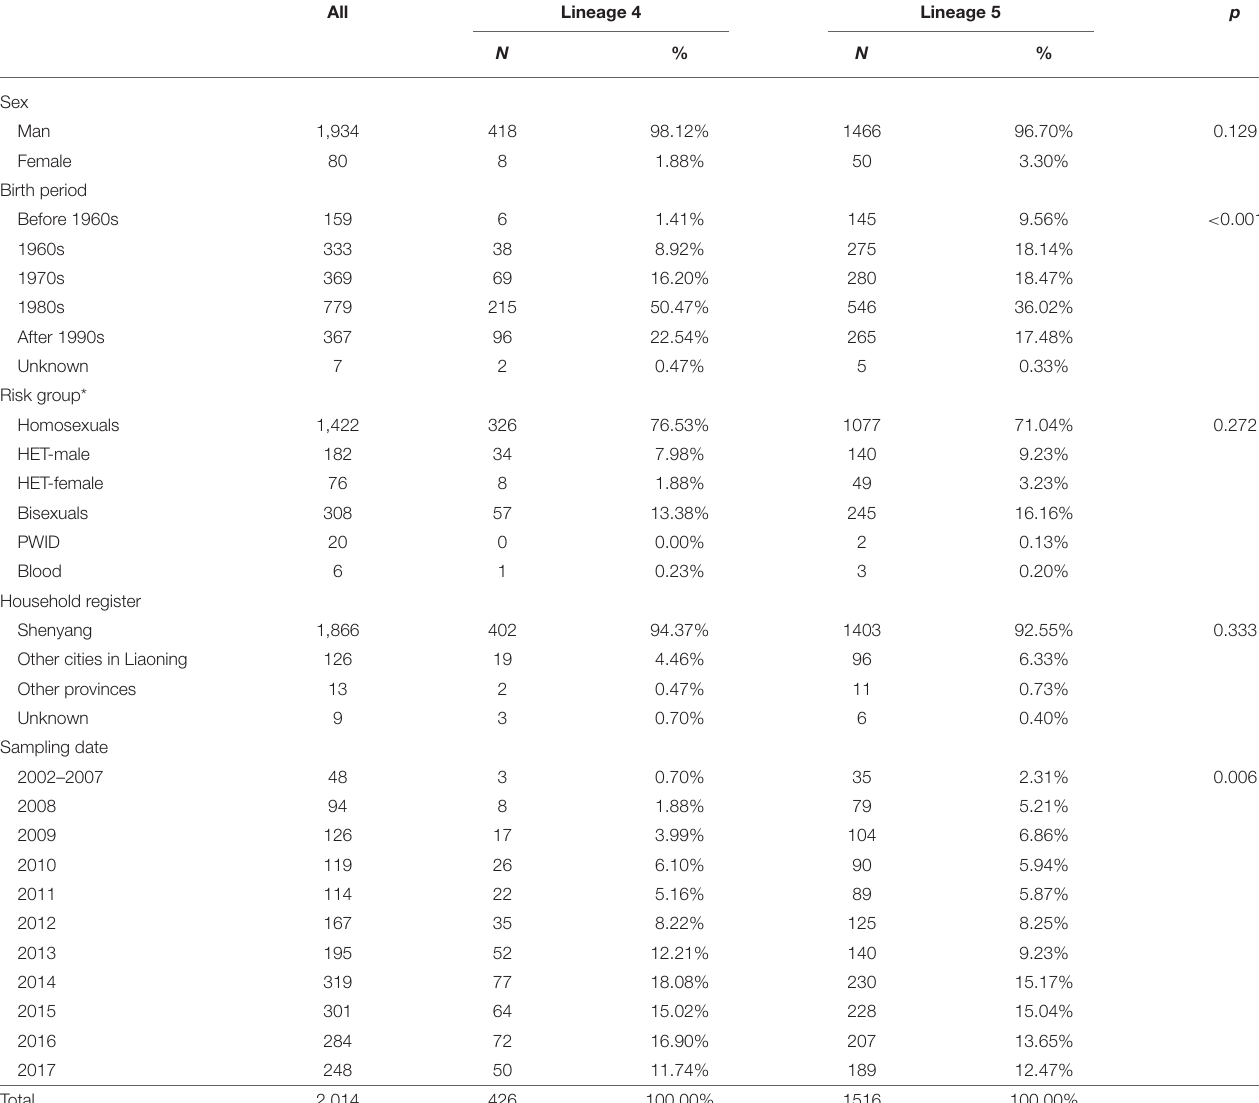
TABLE 1 | Demographic characteristics of HIV-1 CRF01_AE in Shenyang.